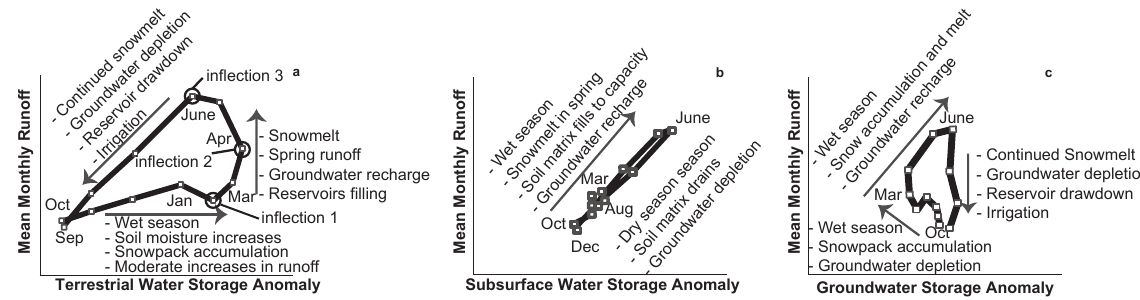
Figure 3. (a–c) Annotated hysteresis curves of terrestrial water storage anomalies (a) , the subsurface water storage anomalies (TWSA sub ; b ), and groundwater storage anomalies (c) based upon the 9-year mean for the Columbia River at The Dalles. These curves describe the fluxes of water moving through the watershed.